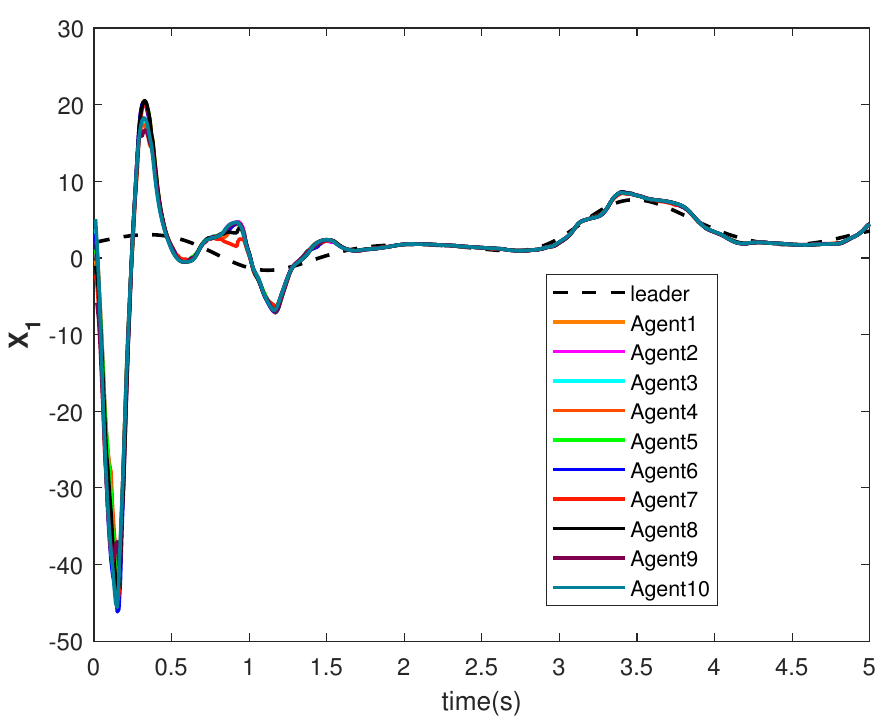
Figure 17. Consensus tracking of state X 1 of the agents.